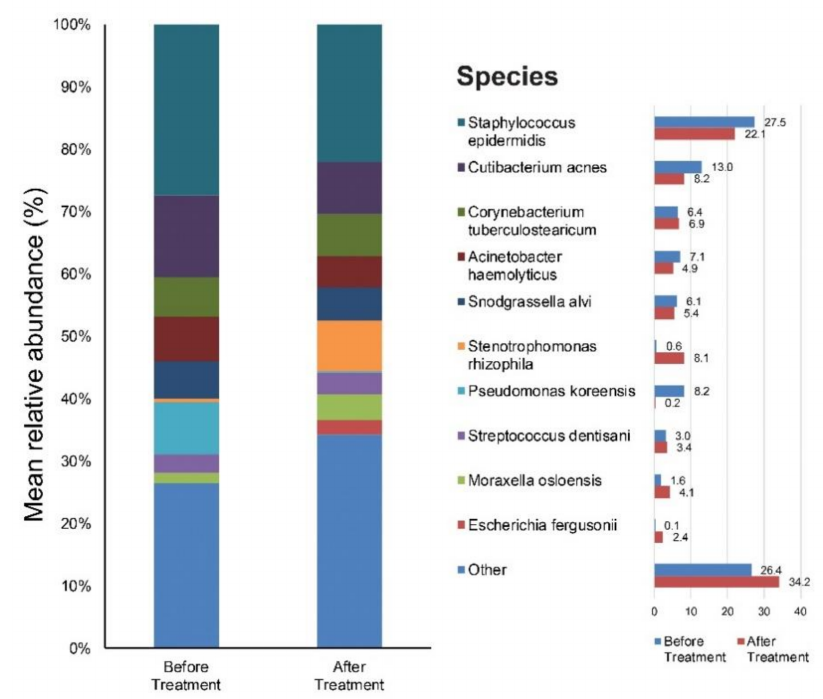
Figure 2. Bar graph on skin microbiota in rosacea patients Before treatment, and after six weeks of doxycycline.